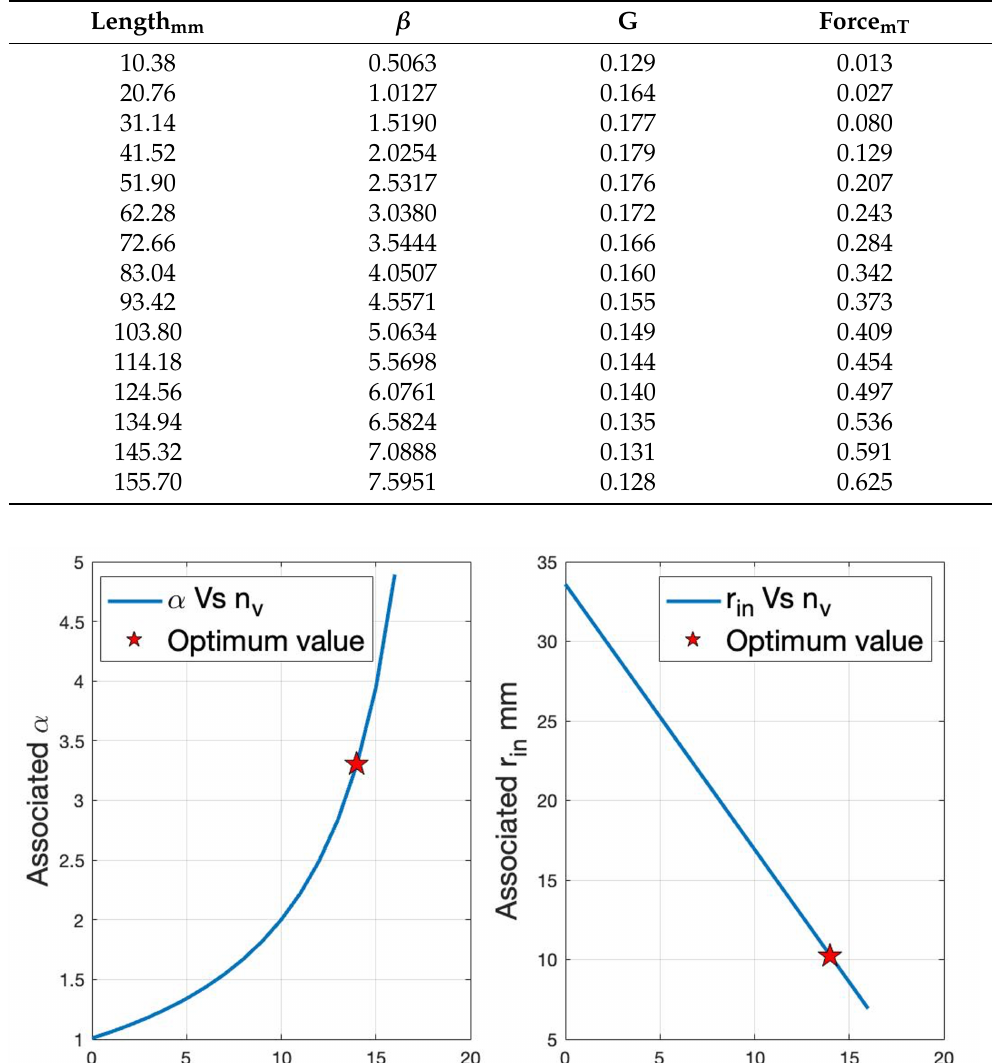
Table 2. Different coils with their generated force.